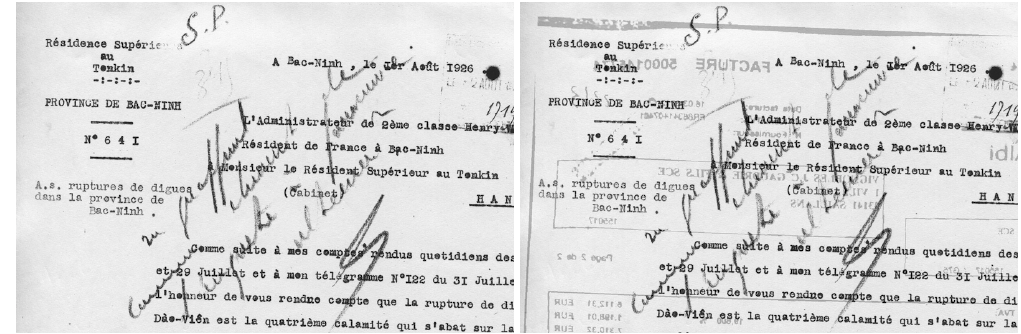
Figure 6. Bleed-through defect. ( Left ) original image. ( Right ) degraded